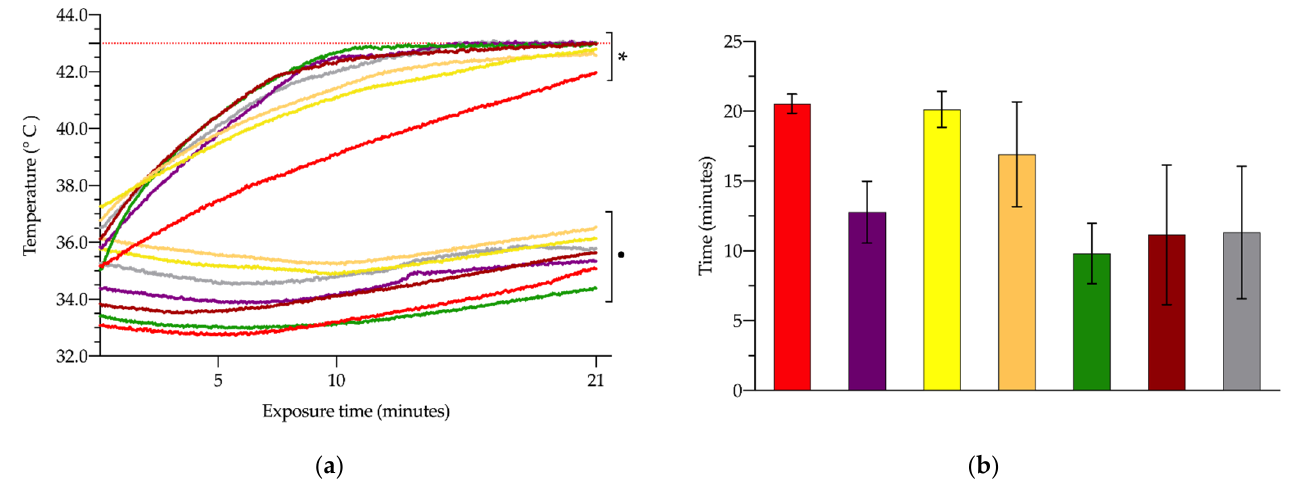
Figure 2. Absolute temperature values ( a ) registered in the liver (asterisk) and rectal probe (dot), after exposure to alternating magnetic field (AMF), with different combinations of intensity and frequency: 14 kA/m and 591 kHz (G1, red); 18 kA/m and 591 kHz (G2, purple); 16 kA/m and 591 kHz (G3, yellow); 13.7 kA/m and 700 kHz (G4, orange); 14.4 kA/m and 774 kHz (G5, green); 11.2 kA/m and 856 kHz (G6, garnet), and 10.3 kA/m and 928 kHz (G7, grey); the upper dotted orange line indicates the upper temperature limit set at 43° C for the hepatic probe, the threshold temperature. Required time to reach the 43° C limit in the hepatic parenchyma ( b ). Table 2. Hepatic and rectal temperatures recorded at the onset (T 0 ) and at the end (T 21 ) of exposure to alternating magnetic fields, and the thermal increase in both tissues.